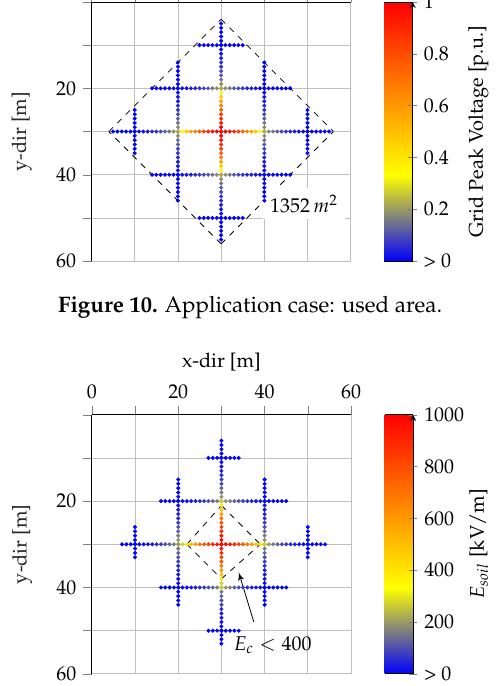
Figure 10. Application Case: Utilized area Figure 11. Application Case: Peak field